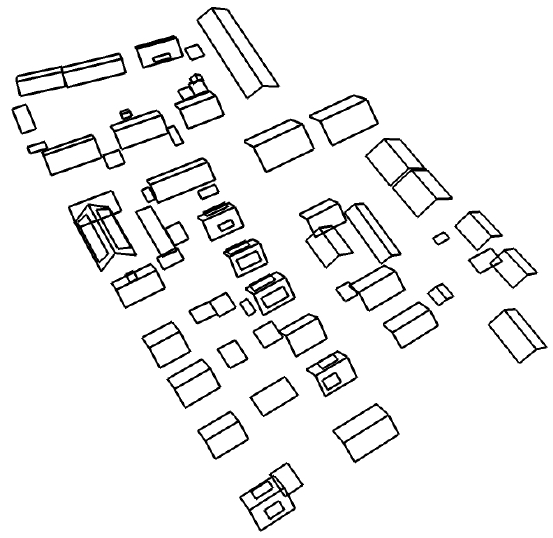
Figure 4. Reconstructed 3D building roofs